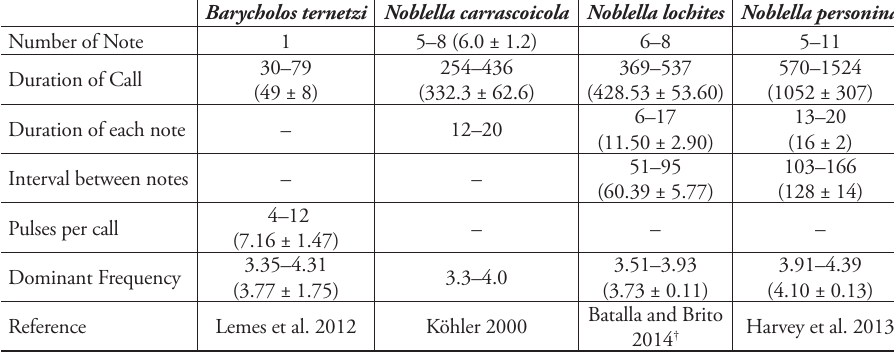
Table 2. Acoustic parameters of advertisement call of Noblella and Barycholos , genera more closely re- lated with Eleutherodactylus bilineatus according to Canedo and Haddad (2012). Temporal variables in miliseconds